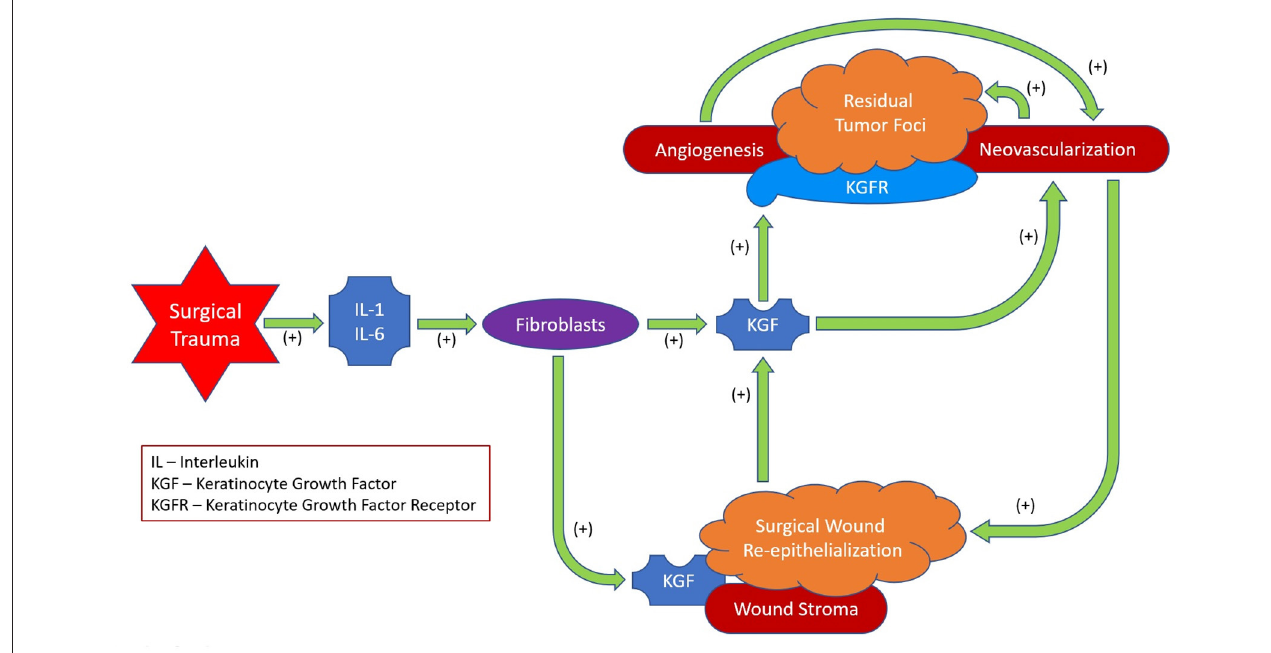
FIGURE 2 | Proposed ramifications of surgical trauma related plasma KGF